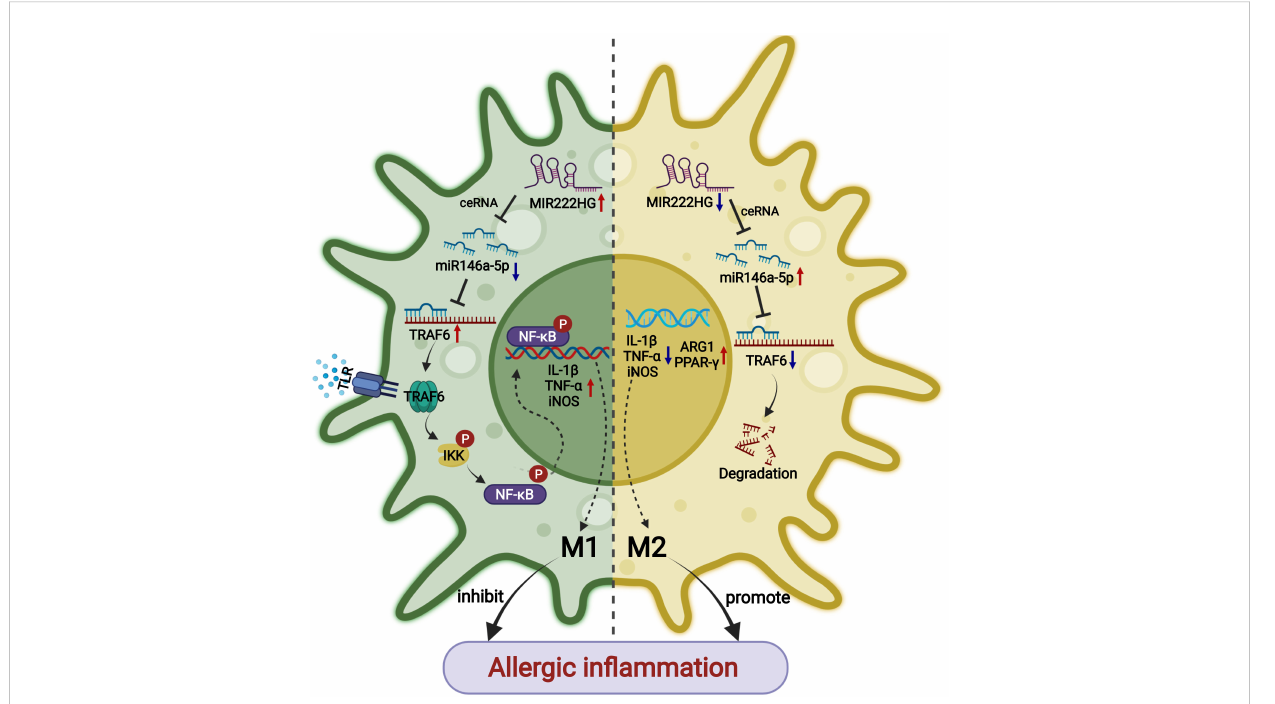
FIGURE 10 A schematic diagram showing that lncRNA-MIR222HG mediates macrophage polarization and suppresses AR by competing with miR146a-5p and activating TRAF6 and the IKK/I k B/P65 signaling